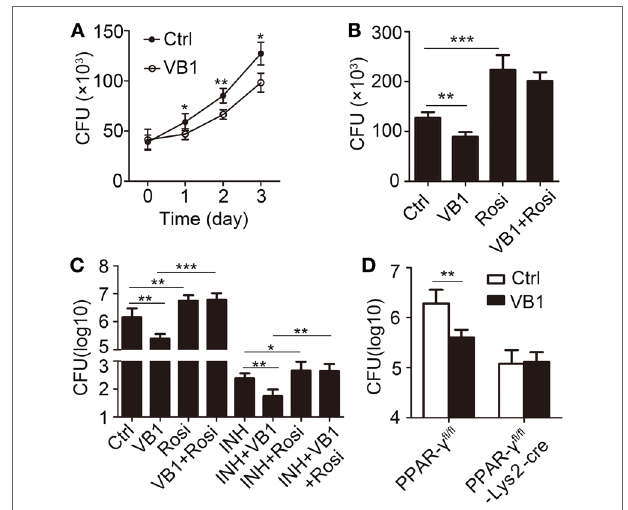
FigUre 6 | The anti-bacillus effect of vitamin B1 (VB1) in macrophages. (a,B) Bone marrow-derived macrophages were pretreated with phosphate buffer saline, VB1, Rosi, or mixture of VB1 and Rosi for 24 h and then challenged with Mycobacterium tuberculosis H37Rv (MOI 5) for 1 h. (a) Intracellular viable bacteria were detected with colony-forming unit (CFU) assays at 0, 1, 2, 3 day post-infection. (B) Intracellular viable bacteria were detected with CFU assays at 72 h post-infection. (c,D) PPAR- γ fl/fl or PPAR- γ fl/fl -Lys2-cre mice were infected with H37Rv (~200 bacteria/mouse). Oral administration with water (Ctrl), VB1, INH, or Rosi ( n = 5 mice/group) was started from the day after infection (day 1) and continued for 2 weeks. CFUs were obtained from the lung cell lysates by serial dilution and plating on 7H10 agars in triplicate. The colonies were counted after 4 weeks. (c) C57BL/6J mice. (D) PPAR- γ fl/fl or PPAR- γ fl/fl -Lys2-cre mice. Data shown are the mean ± SD. * P < 0.05, ** P < 0.01, and *** P < 0.001. Data are representative of three independent experiments with similar